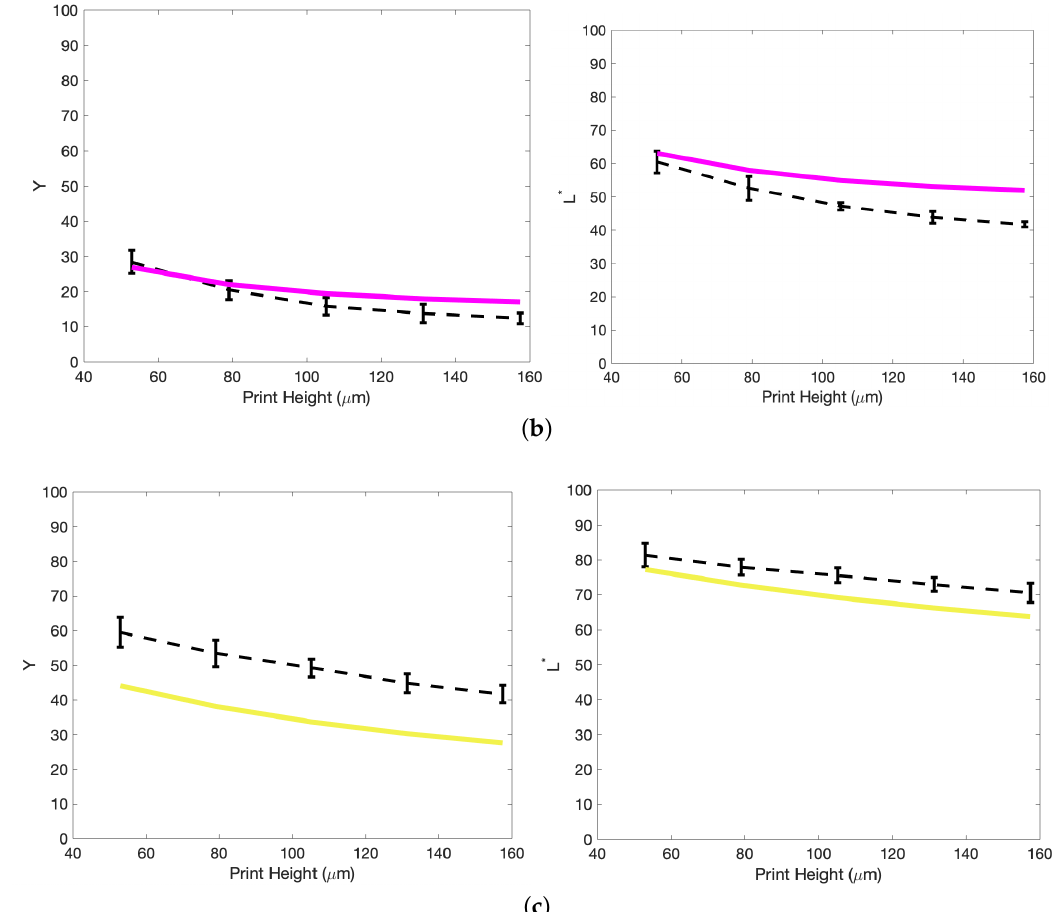
Figure 12. Results and corresponding predicted fitting for the lightness components, Y and L ∗ , of the step-wedge prints. These are listed individually as ( a ) cyan, ( b ) magenta and ( c ) yellow. The dashed black line represents the data taken from the prints averaged over three measurements, while the solid line represents the predicted curve, with absorption K and scattering S coefficients chosen for the greatest fit.